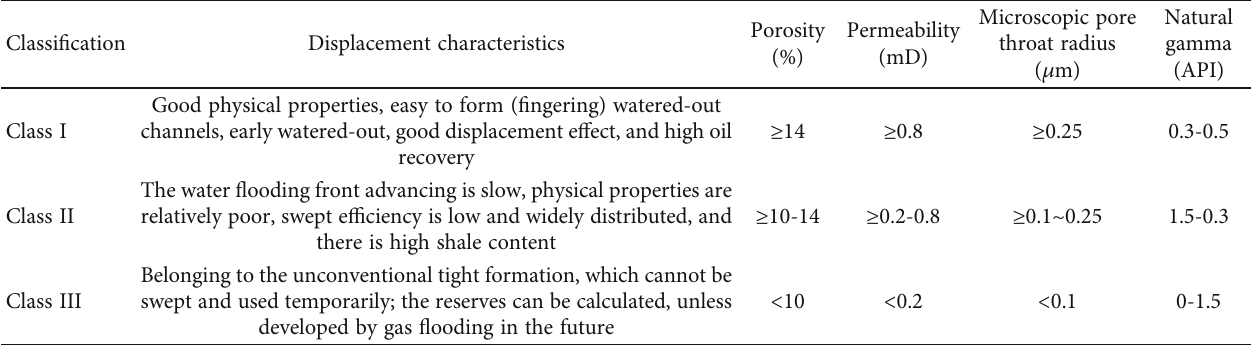
Table 3: Classi fi cation standard of a single sand body oil reserves